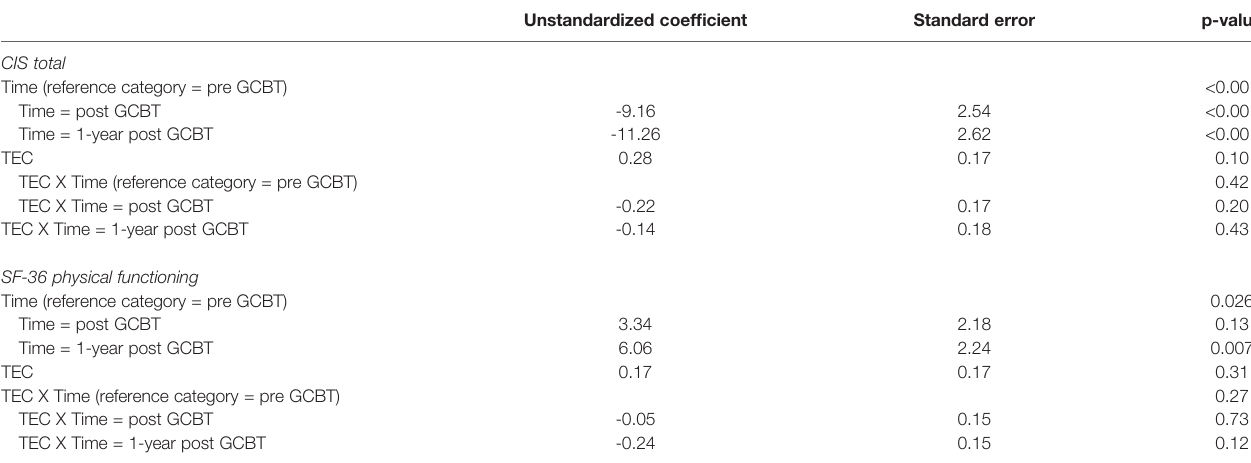
TABLE 3 | Summary of the results of the linear mixed model